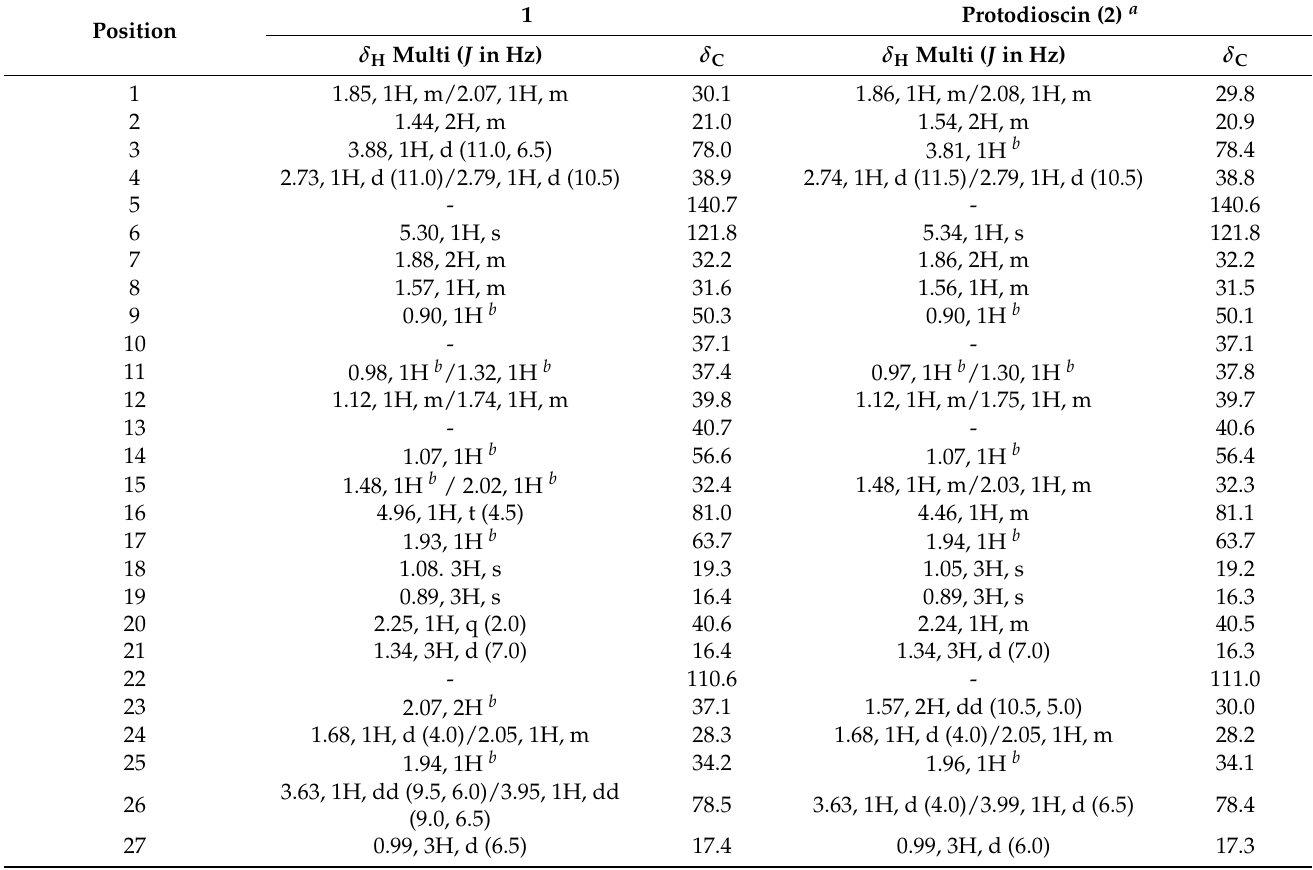
Table 1. 1 H- and 13 C-NMR spectroscopic data for the aglycones of compounds 1 and 2 ( δ in ppm, C 5 D 5 N, 800 and 200